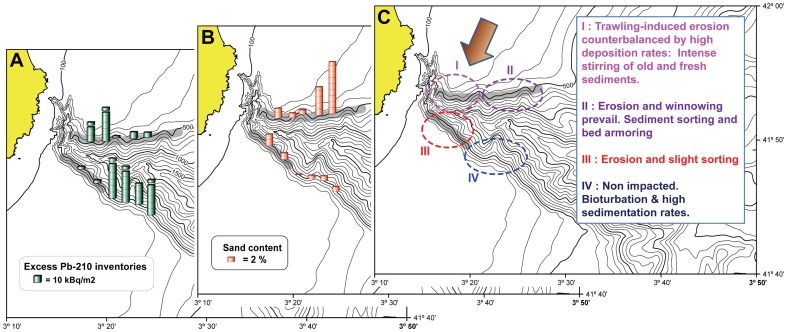
Trawled/untrawled and inshore/offshore gradients in the flanks of La Fonera Canyon.Excess 210Pb inventories (A); sand content in the upper 10 cm of the sediment column (B); interpretative summary of the results (C). Cropped bars in the 210Pb inventories indicate that the 210Pb supported level was not reached and consequently these inventories represent lower estimates of the excess 210Pb accumulated at each site. The arrow indicates the approximate position of the main along-shelf sediment transport. Coordinates are East and North degrees/minutes for longitude and latitude respectively.